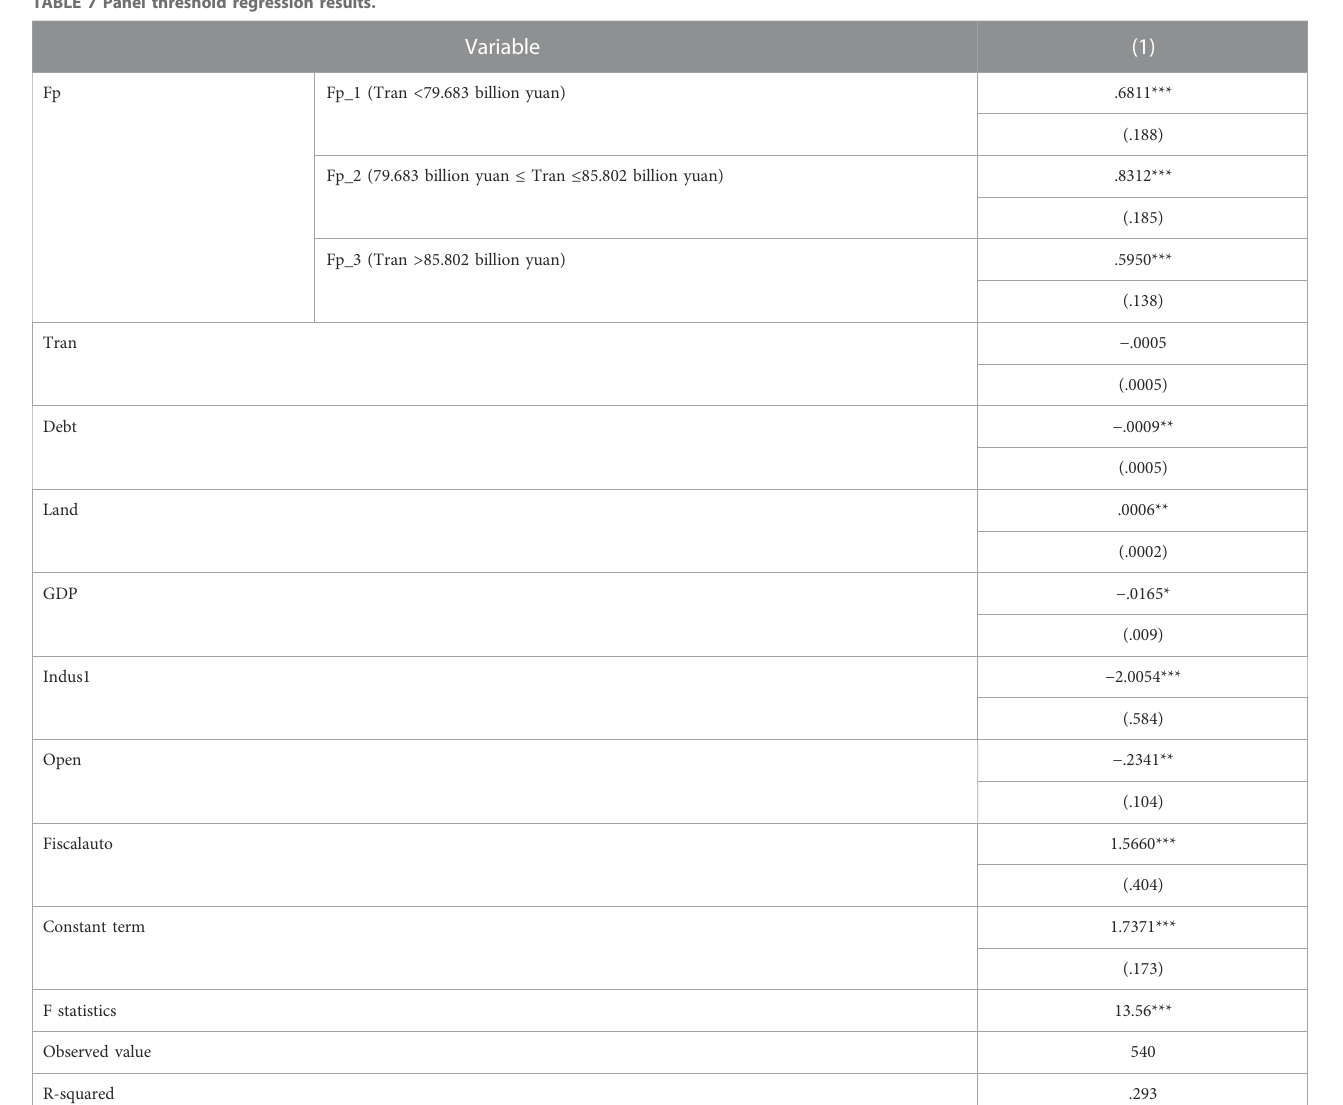
TABLE 7 Panel threshold regression